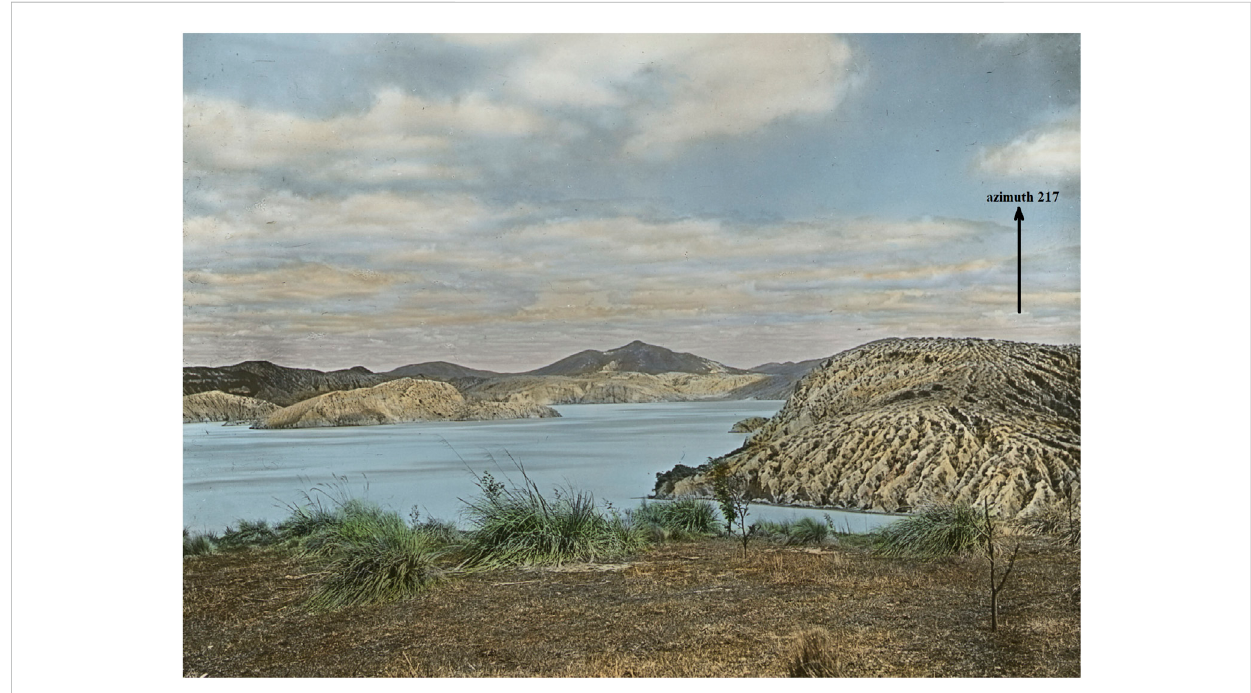
FIGURE 7 Patiti Island lantern slide c. 1910, taken from the Tourist Track landing on a 217 ° azimuth (Rose Archives, SUNY Brockport, Brockport, NY).